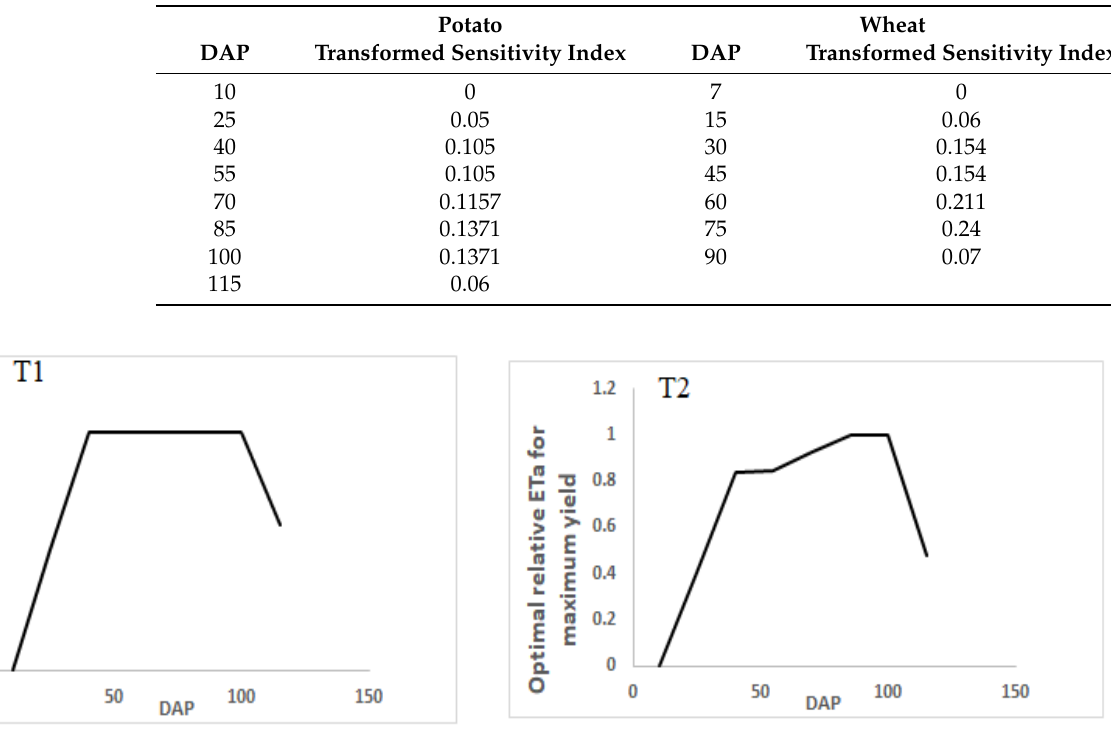
Figure 7. Cumulative-sensitivity-index curve. Table 7. Transformed moisture stress-sensitivity index in fifteen-days interval.